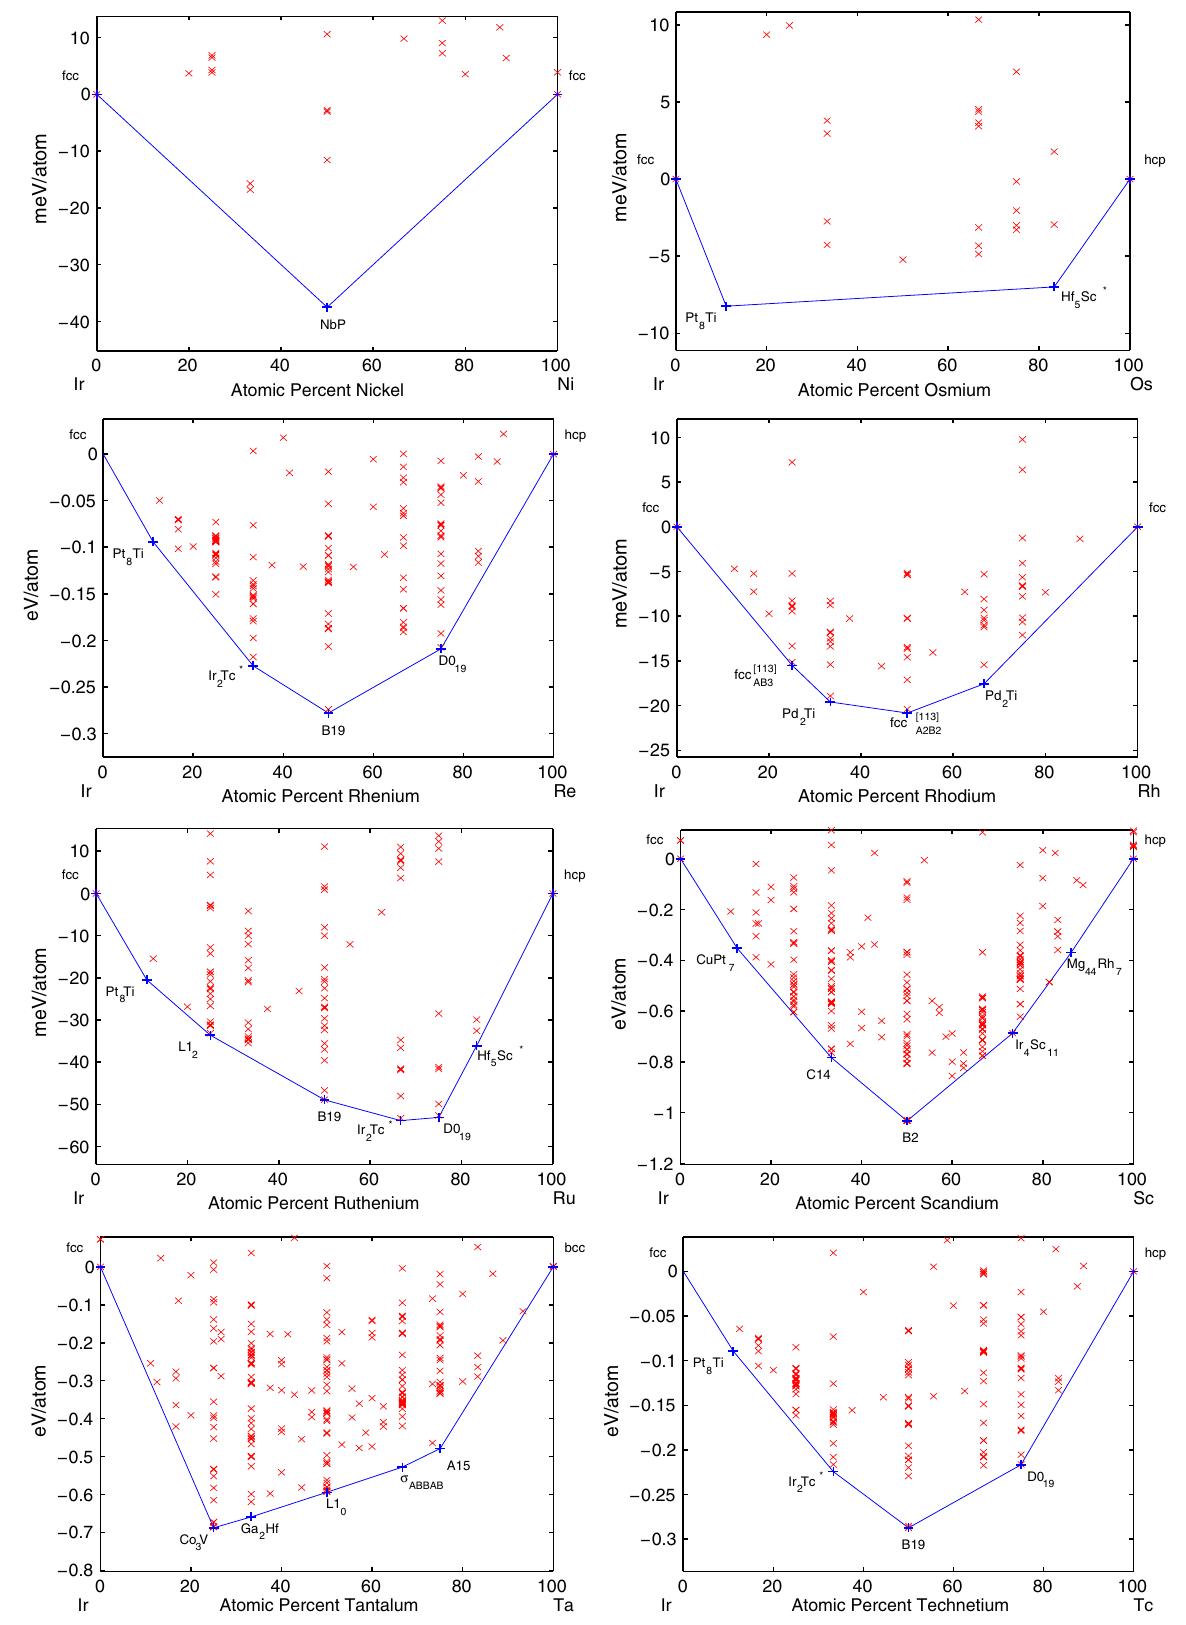
FIG. 9. Convex hulls for the systems Ir-Ni, Ir-Os, Ir-Re, Ir-Rh, Ir-Ru, Ir-Sc, Ir-Ta, and